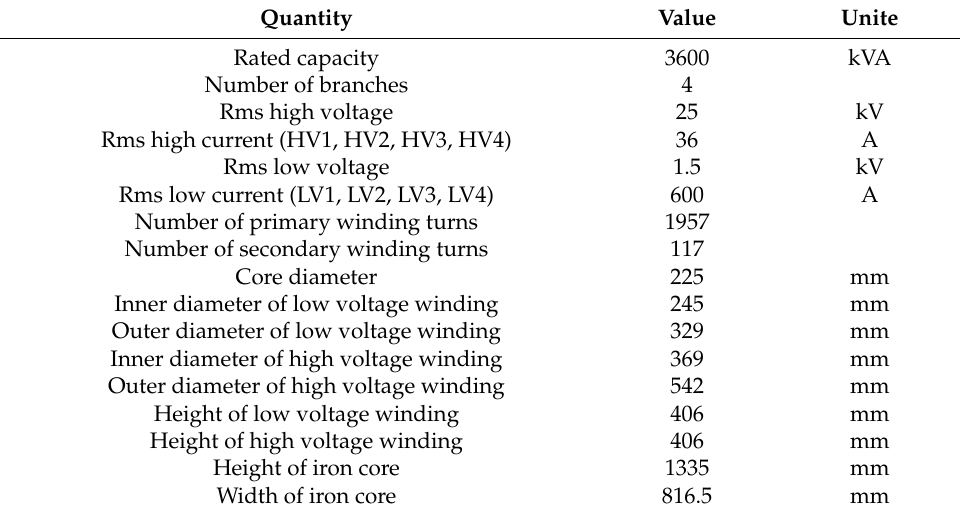
Table 1. Basic parameters of transformer.